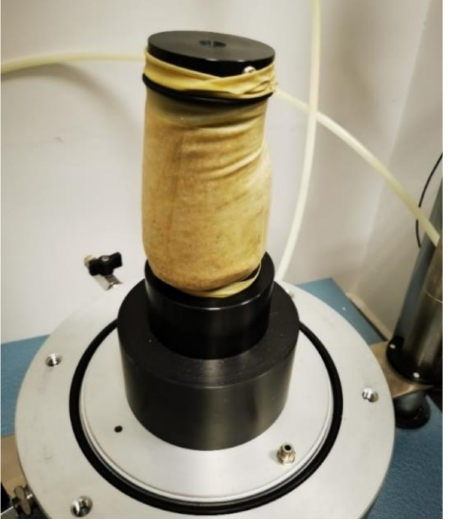
Figure 6. View of the damaged gravelly sand sample during test sequence